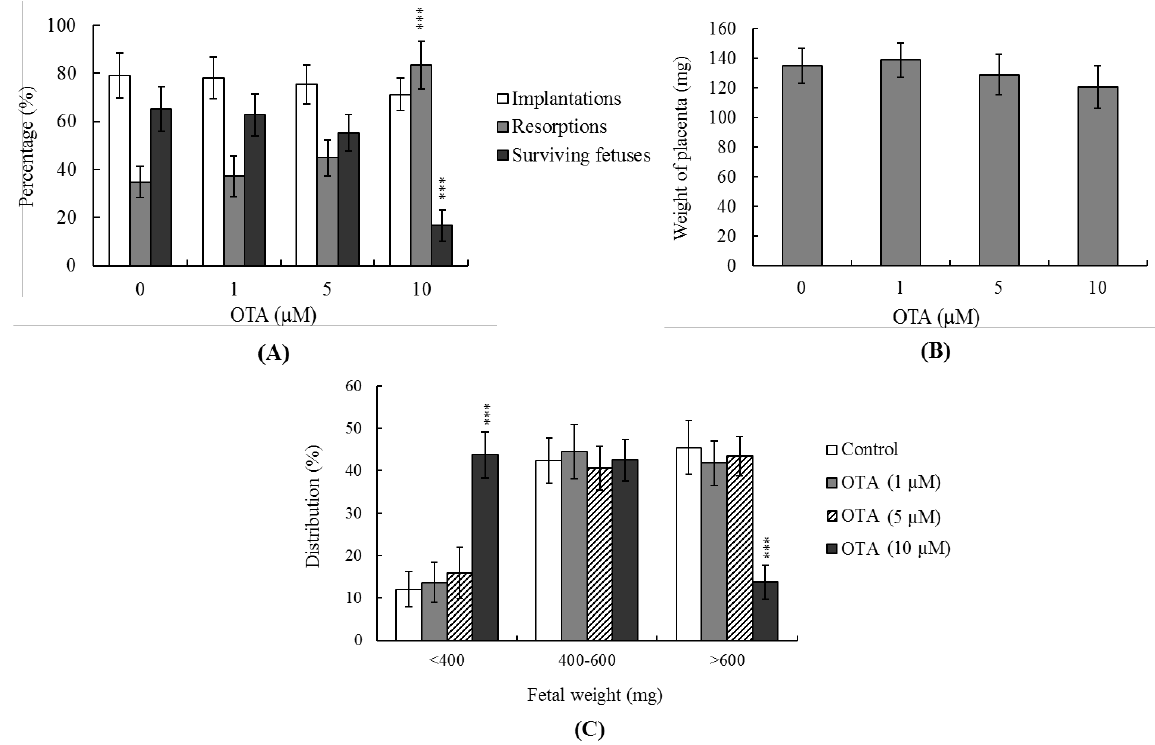
Figure 4. Effects of OTA on mouse blastocysts in terms of in vivo implantation, resorption, fetal survival and fetal weight. ( A ) Mouse blastocysts were treated with OTA (1, 5, or 10 μM) for 24 h, or left untreated. Implantation, resorption, and numbers of surviving fetuses, were analyzed, as described in Materials and Methods. The implantation proportions represent the number of implantations per transferred embryo, ×100. The proportions of resorption or fetal survival are the numbers of resorptions or surviving fetuses per-implantation, ×100; ( B ) Placental weights were measured in each of 40 recipient mice; ( C ) Weight distribution of surviving fetuses on day 18 post-coitus. Surviving fetuses were obtained via embryo transfer of control and OTA-pretreated blastocysts, as described in Materials and Methods (a total of 320 blastocysts were transferred to 40 recipients). *** p < 0.001 versus the OTA-free